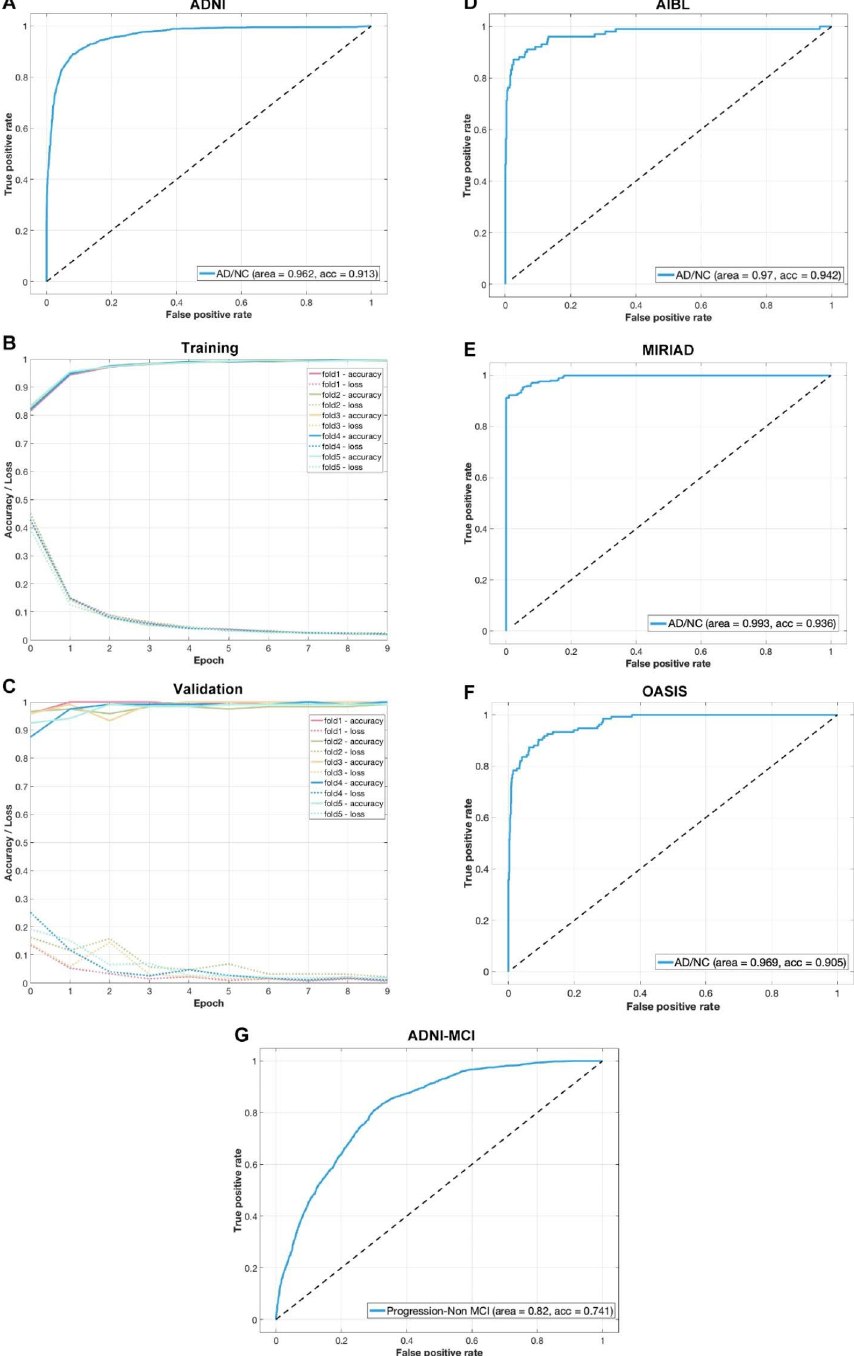
Fig. 3 Performance of the Alzheimer’s disease (AD) classifier. Left panel shows the training and testing perfor- mance of the AD classifier on ADNI sample. Right panel shows the testing performance of the AD classifier on independent samples. ( A ) The receiver operating characteristic curve of the AD classifier. ( B ) The tensorboard monitor panel of the AD classifier in the training sample. ( C ) The tensorboard monitor panel of the AD classifier in the validation sample. ( D ) The ROC curve of AD classifier tested on the AIBL sample. ( E ) The ROC curve of the AD classifier tested on the MIRIAD sample. ( F ) The ROC curve of the AD classifier tested on the OASIS sample. ( G ) The ROC curve of the AD classifier tested on the ADNI MCI